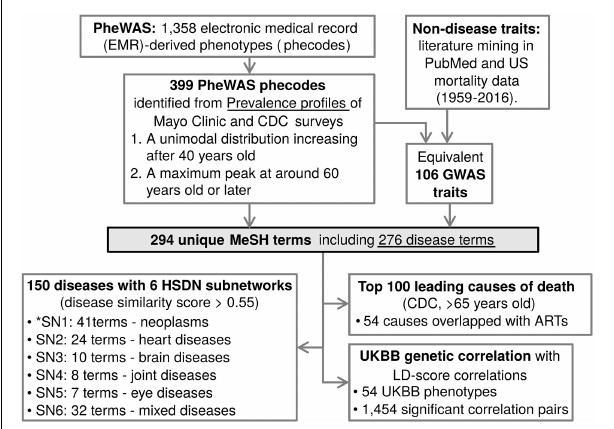
FIGURE 1 | Identified age-related traits and diseases annotations for genetic resources. A schematic of the analysis flow of this study. From the PheWAS and GWAS catalogs, ARTs were identified, converted to Medical Subject Headings (MeSH) terms, and overlaid onto a human symptom-disease network (HSDN), top 100 leading causes of death, and UKBB genetic correlation data. *SN means